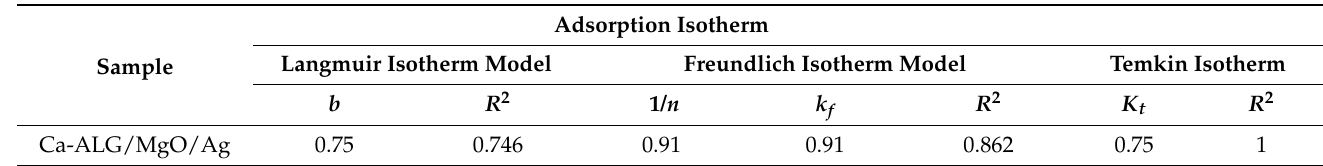
Figure 10. ( a ) Langmuir isotherm model, ( b ) Freundlich isotherm model, and ( c ) Temkin isotherm of Ca-ALG/MgO/Ag nanocomposite beads. Table 2. Langmuir isotherm model, Freundlich isotherm model, and Temkin isotherm of Ca- ALG/MgO/Ag nanocomposite beads.